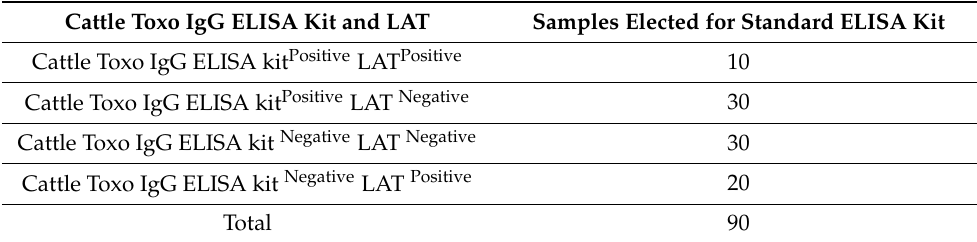
Table 1. Election of sera for standard ELISA kit using LAT, Cattle Toxo IgG ELISA Kit. Cattle Toxo IgG ELISA Kit and LAT Samples Elected for Standard ELISA Kit